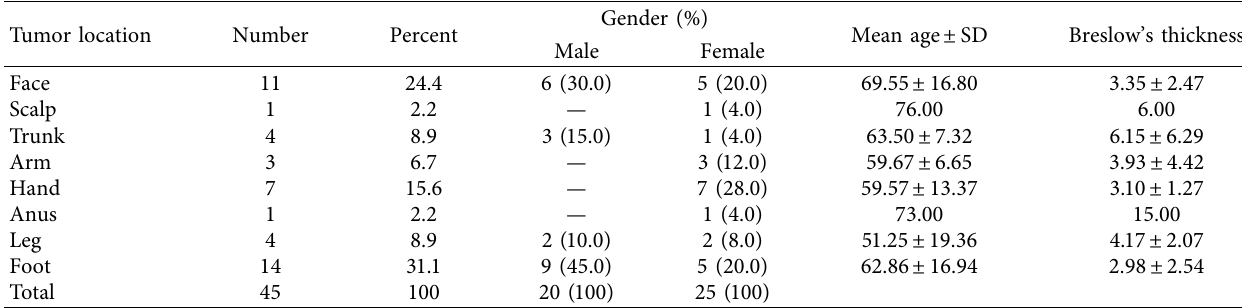
Table 3: The frequency distribution of lesion site based on sex, age, and Breslow thickness.